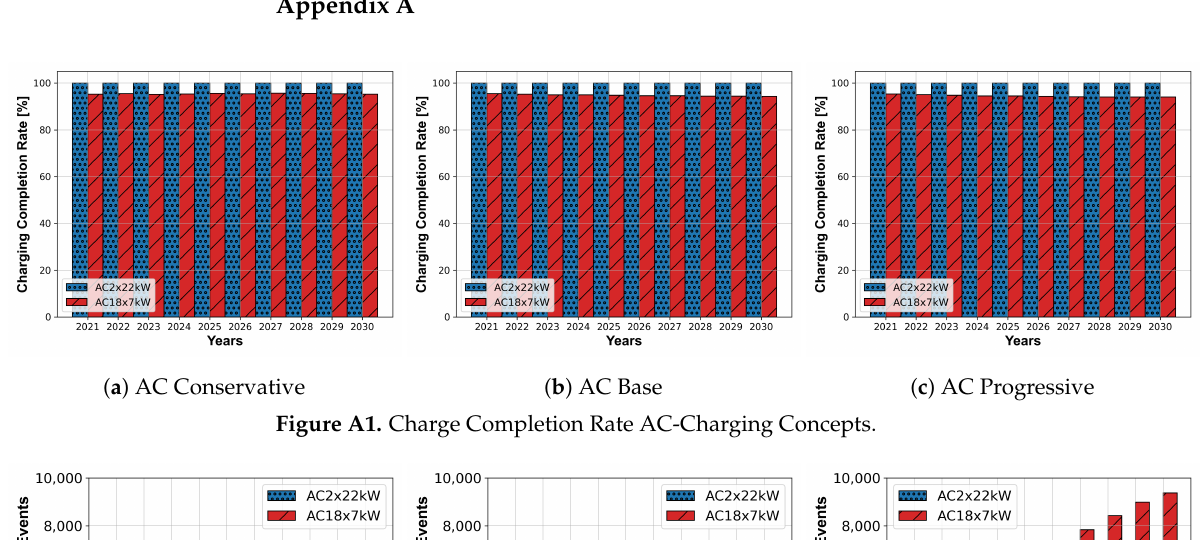
Figure A1. Charge Completion Rate AC-Charging Concepts.